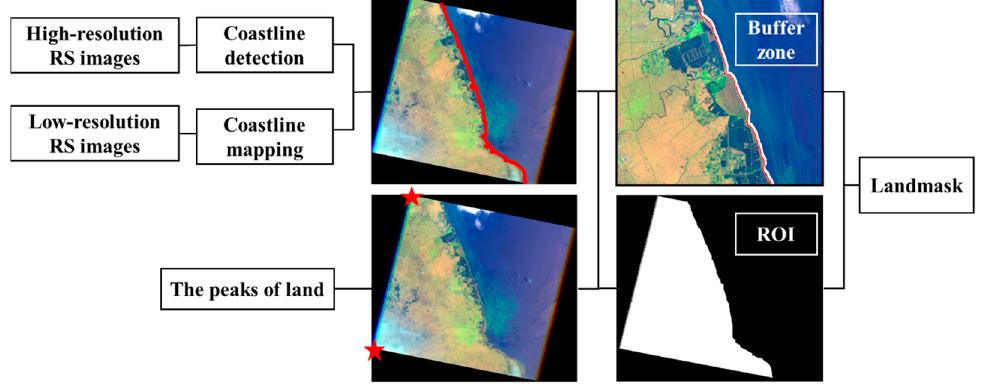
Figure 2. Terrestrial masking